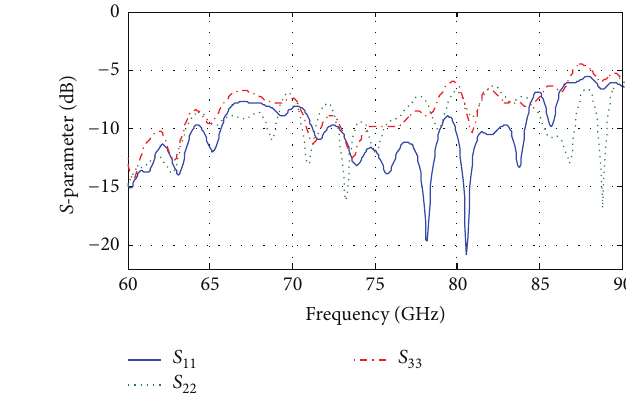
Figure 10: Return loss (dB) over frequency.